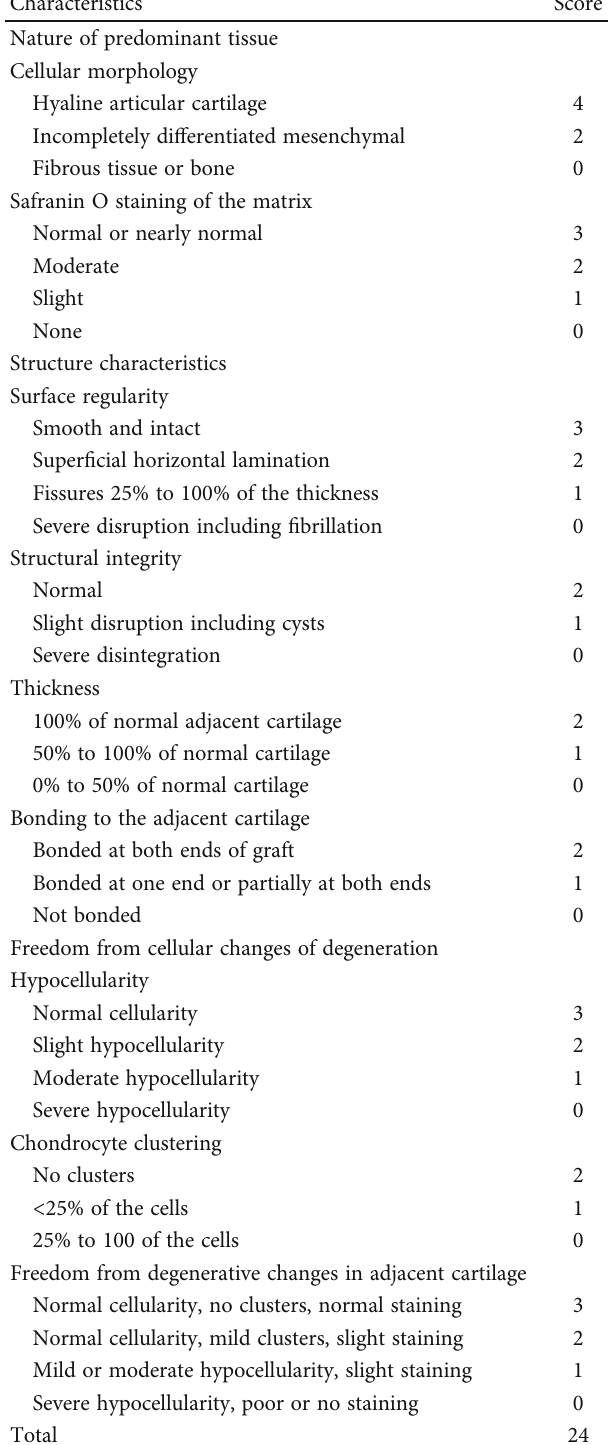
Table 2: O ’ Driscoll histological cartilage repair